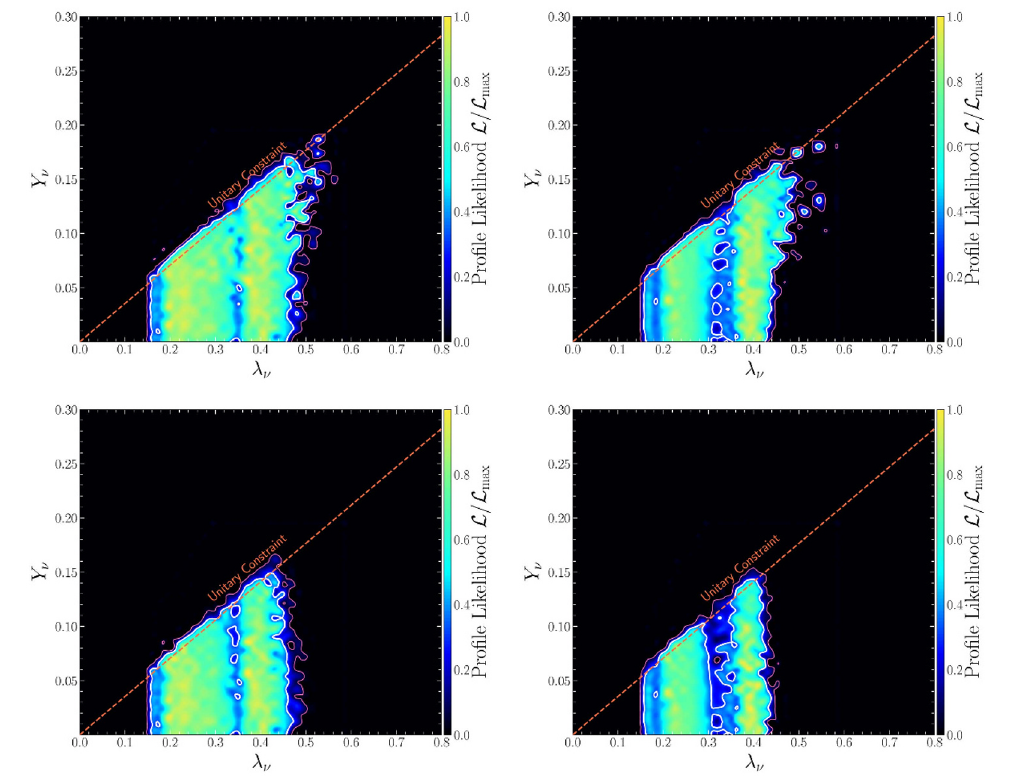
Figure 3 . Same as figure 1, but for the profile likelihood projected onto Y ν − λ ν plane, where the red line denotes the leptonic unitarity